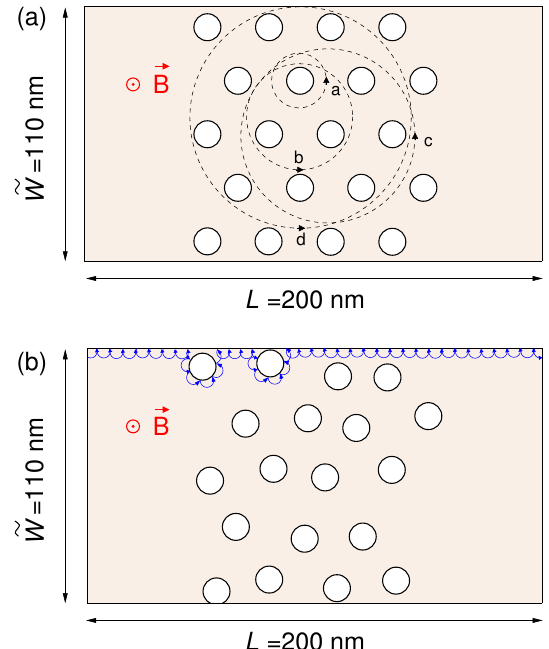
Figure 1. Considered graphene ribbon with a regular ( a ) and an irregular ( b ) distribution of circular